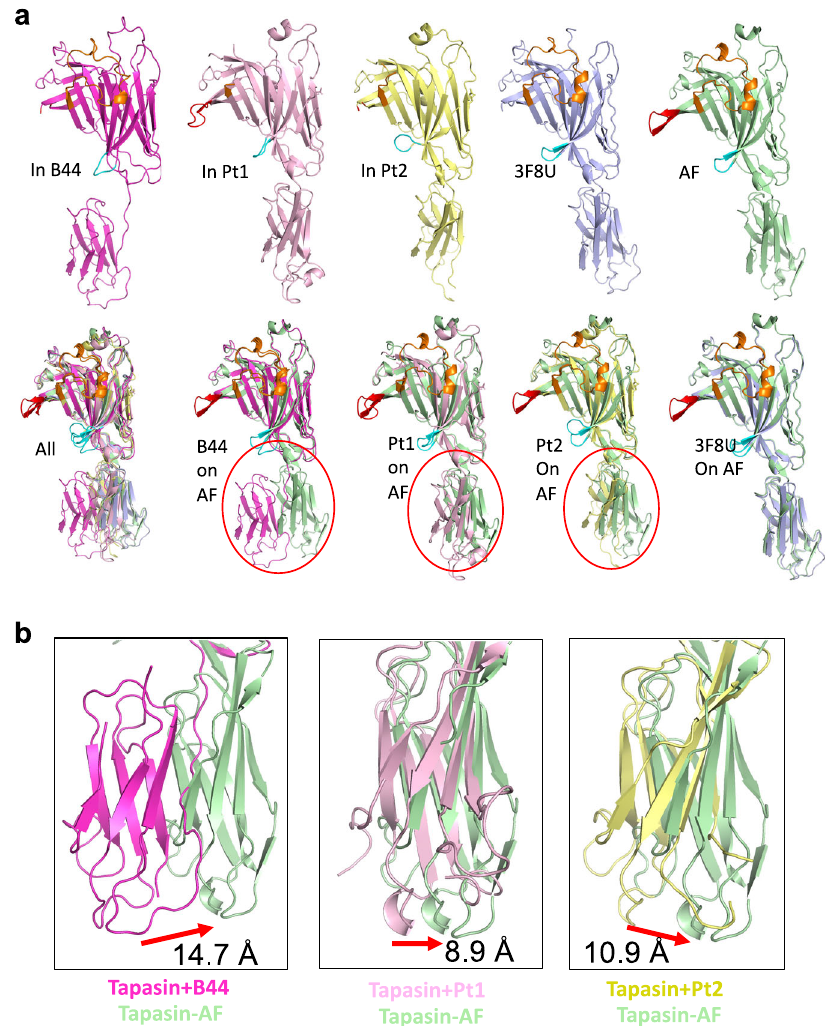
Fig. 5 | Comparison of Tapasin – Domain movements. a First row: ribbon illus- tration of tapasin from complexes: tapasin+B4405 (magenta)(7TUE), tapasin +PaSta1 (light pink)(Pt1, 7TUF), tapasin+PaSta2 (pale yellow)(Pt2, 7TUG), tapasin +Erp57 (3F8U, light blue), and AlphaFold model (from AlphaFold DB in March, 2022)of unliganded tapasin(AF,pale green);second row: all superposed based on N – IgVdomains,andindividualstructuresonAF. b IgCdomainmovementfromAF: shiftis14.7Å,8.9Å,and10.9ÅfortapasincomplexedtoB4405,PaSta1,andPaSta2